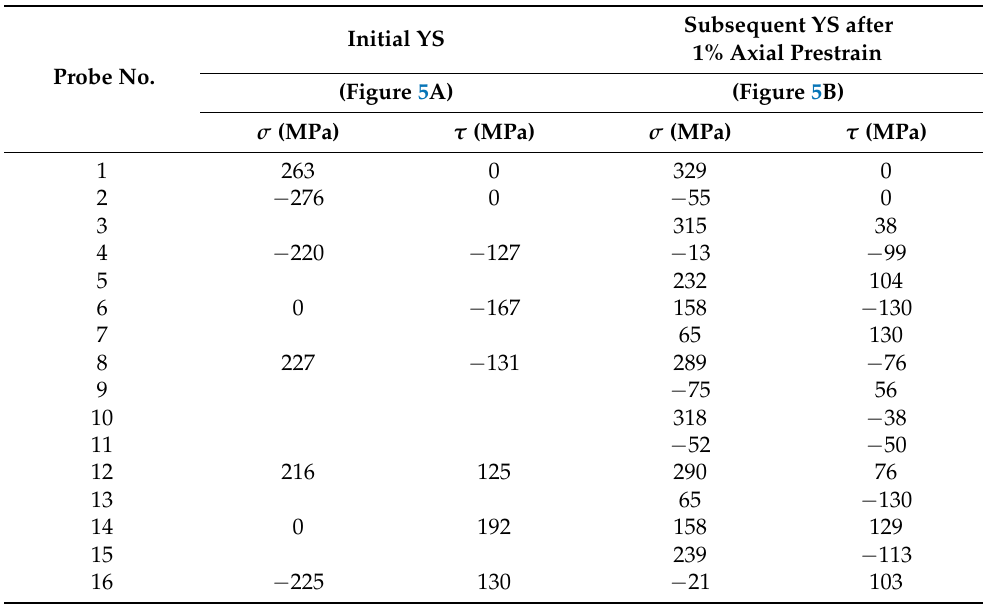
Table A1. Tabular results of YS tracing in P250GH steel—the yield points evaluated within individ- ual probes.